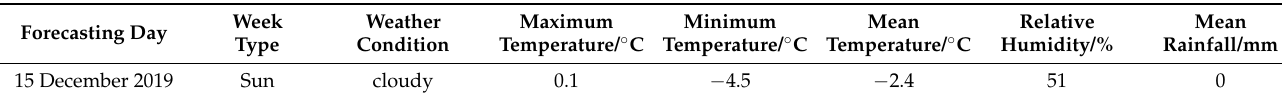
Table 3. Forecasting day meteorological and date type parameters.